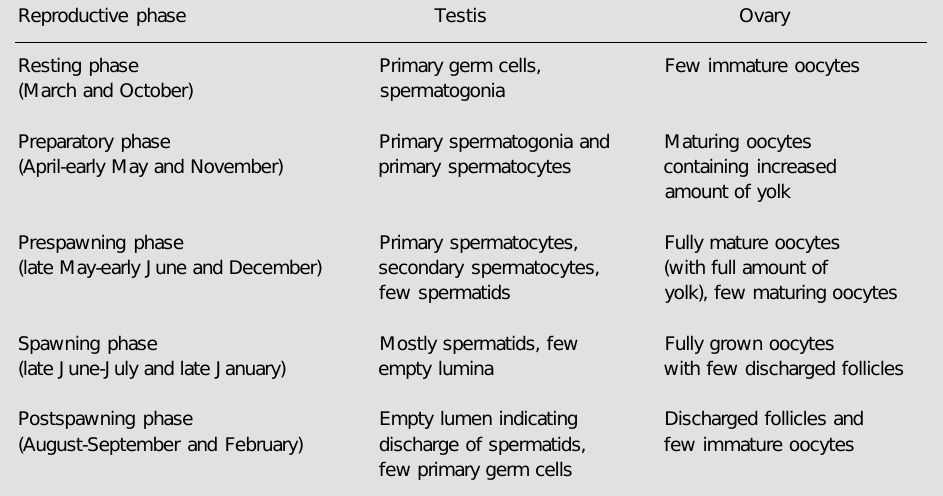
Table 1 - Annual gonadal cycle of Channa punctatus